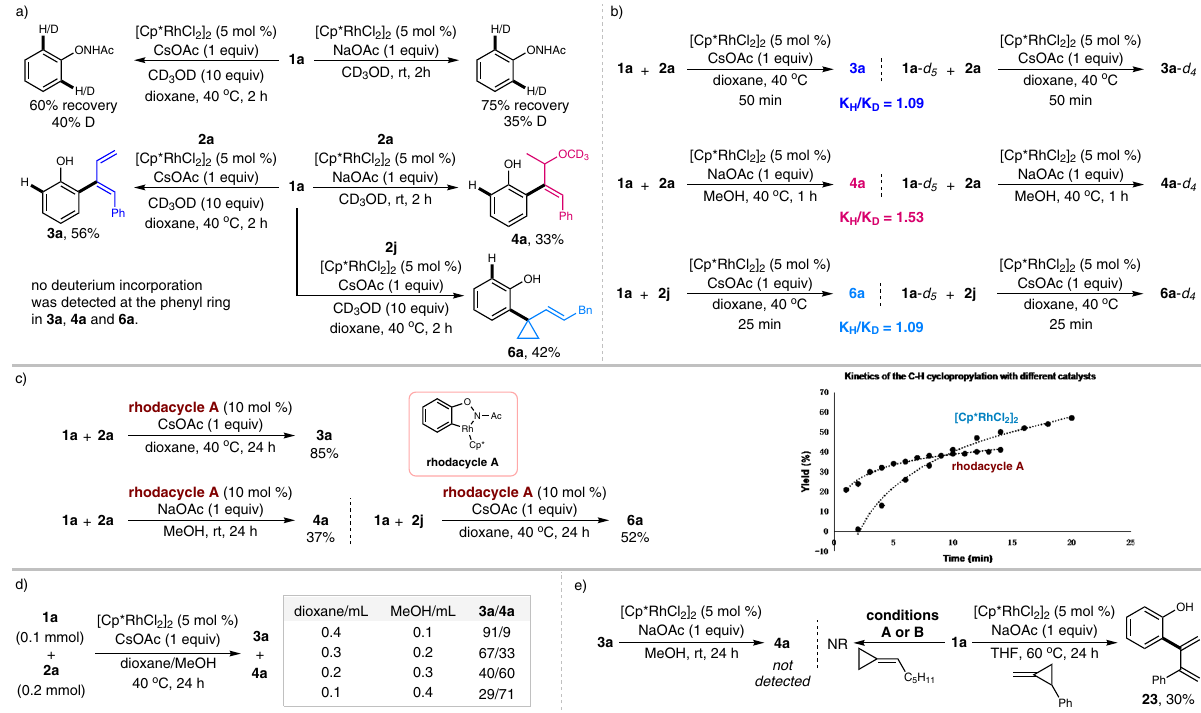
Fig. 7 Experimental mechanistic studies. a Deuterium-labeling experiments. b Kinetic isotope studies. c De fi ning the fi ve-membered rhodacycle as the active intermediate. d Studies on the solvent effect. e Control